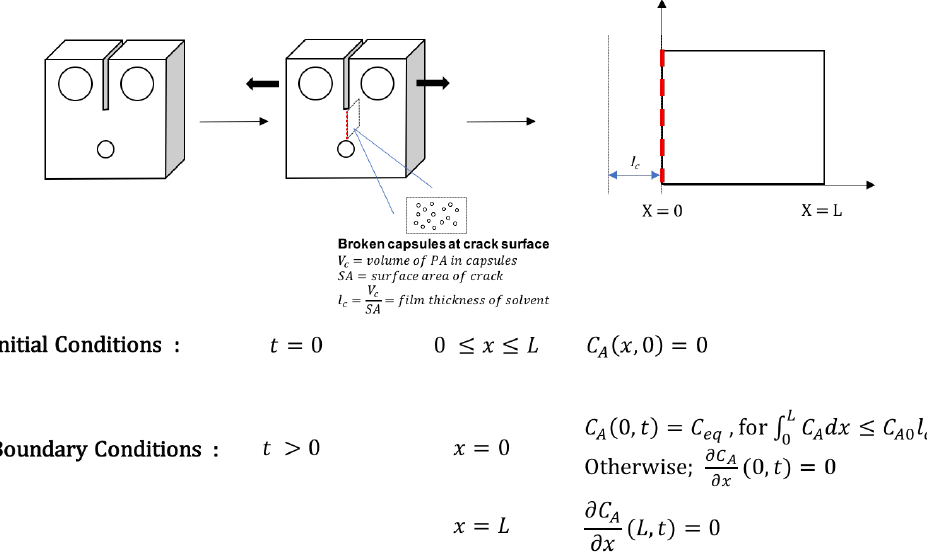
Figure 9. Schematic of model for diffusion of phenyl acetate through compact tension specimen fracture surface.